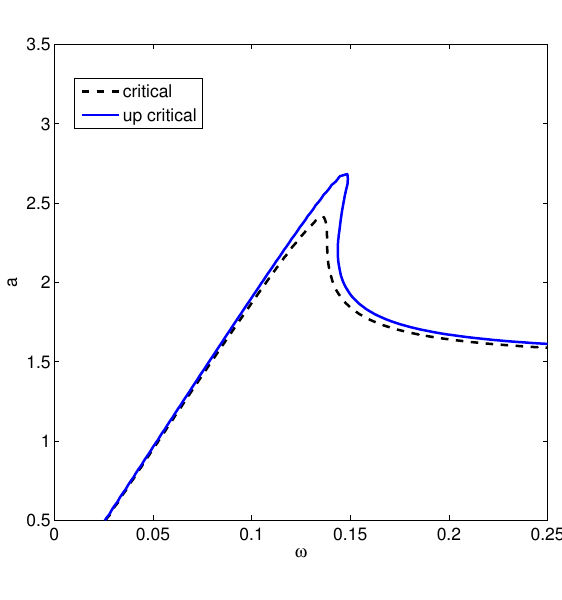
Figure 3. Frequency-response curves to show the critical forcing amplitude for the quasi-zero stiffness oscillator as cal- culated using the proposed method (dotted line) and a slightly larger value than this (solid line) extracted from [10]. Data plotted using γ = 3 . 3 × 10 − 3 , ξ = 0 . 04 . In this case the critical forcing amplitude can be analytically obtained (see